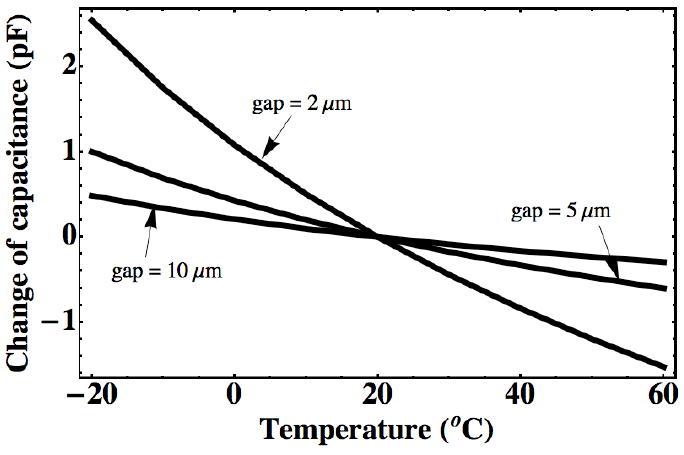
Figure 4. The relation of cavity capacitance change and temperature calculated by large-deflection model with different cavity gap and initial sealed gas pressure of 100 kPa. The radius of the diaphragm is 1 mm, and the thickness is 5 μ